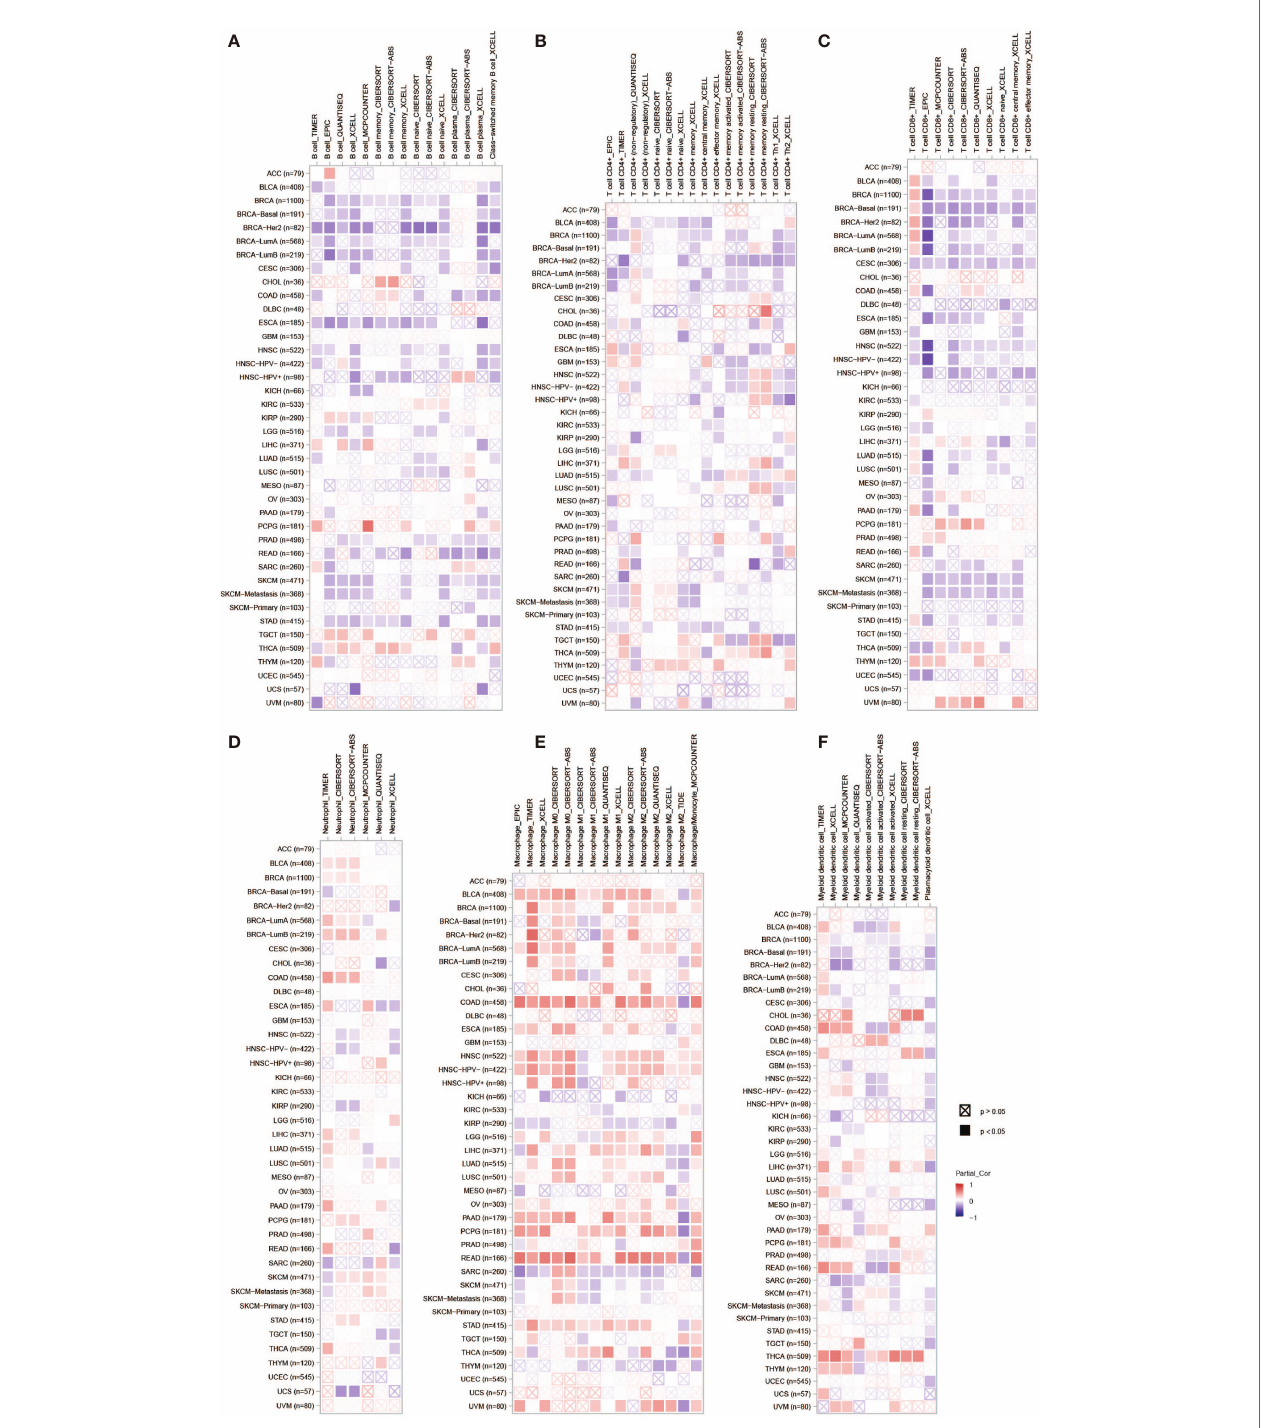
FIGURE 13 | The correlation between PLPP4 and immune cell in fi ltration in cancers. A comprehensive analysis of the correlation between PLPP4 and six immune cell in fi ltrations (B cells, CD4+ T cells, CD8+ T cells, neutrophils, macrophages, and dendritic cells) was performed using TIMER web server. (A) The correlation between PLPP4 and B cells in fi ltrations. (B) The correlation between PLPP4 and CD4+ T cells in fi ltrations. (C) The correlation between PLPP4 and CD8+ T cells in fi ltrations. (D) The correlation between PLPP4 and neutrophils in fi ltrations. (E) The correlation between PLPP4 and macrophages in fi ltrations. (F) The correlation between PLPP4 and dendritic cells in fi